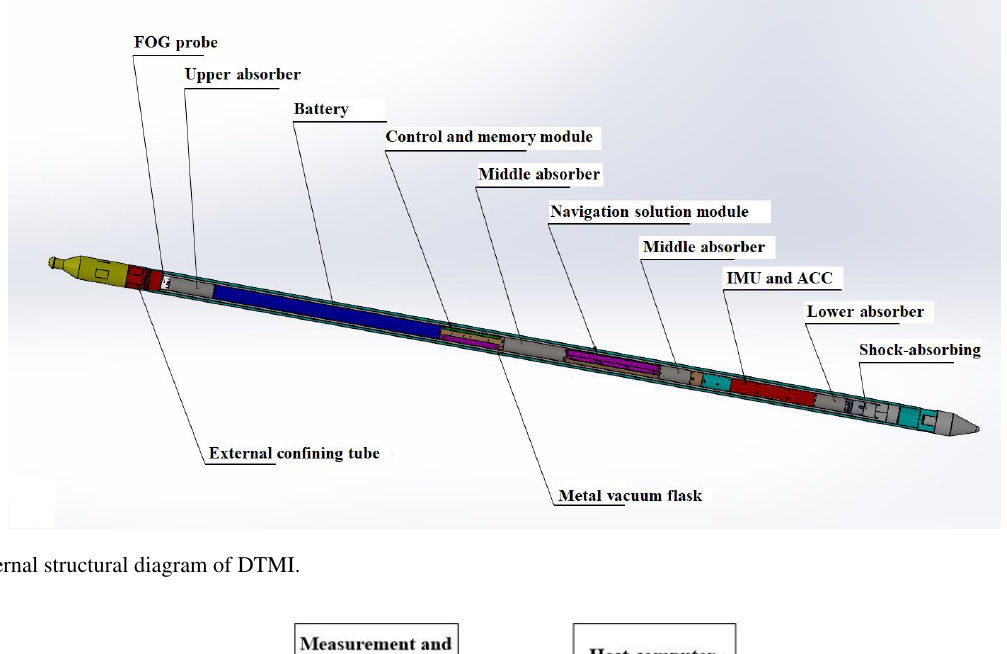
Figure 3. Internal structural diagram of DTMI.